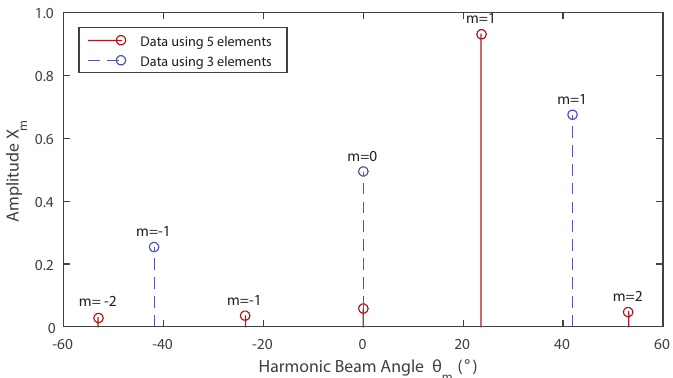
Figure 4. Power spectrum produced by a five-element array receiving a signal from a source at an angle of 25 ◦ . When the samples from the outer elements are removed, then the array produces a new spectrum with different characteristics (shown as the dotted lines in the figure).